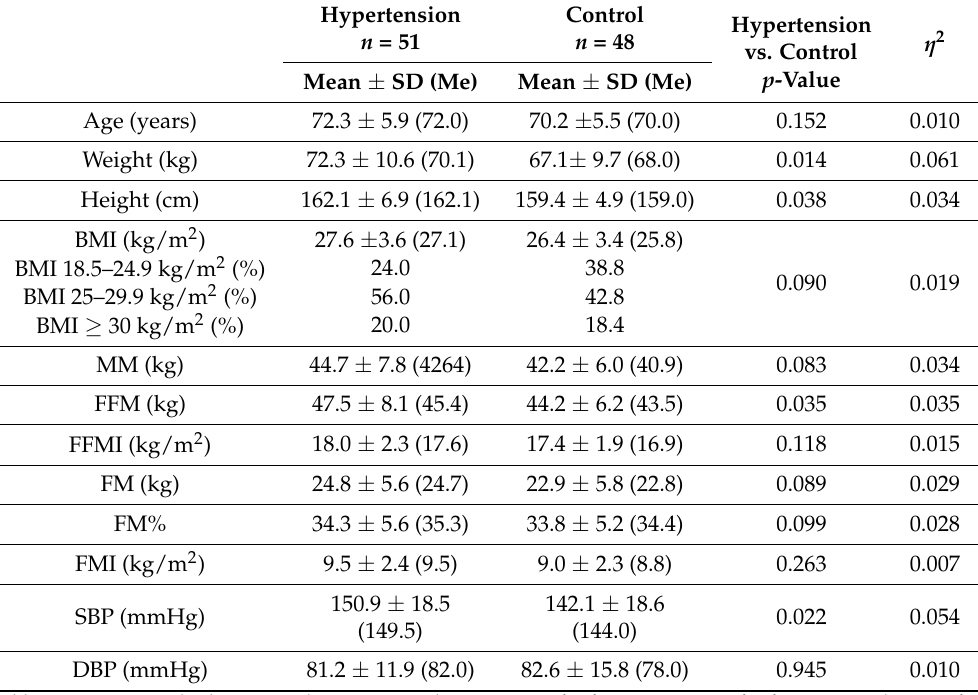
Table 1. Anthropometrics and body